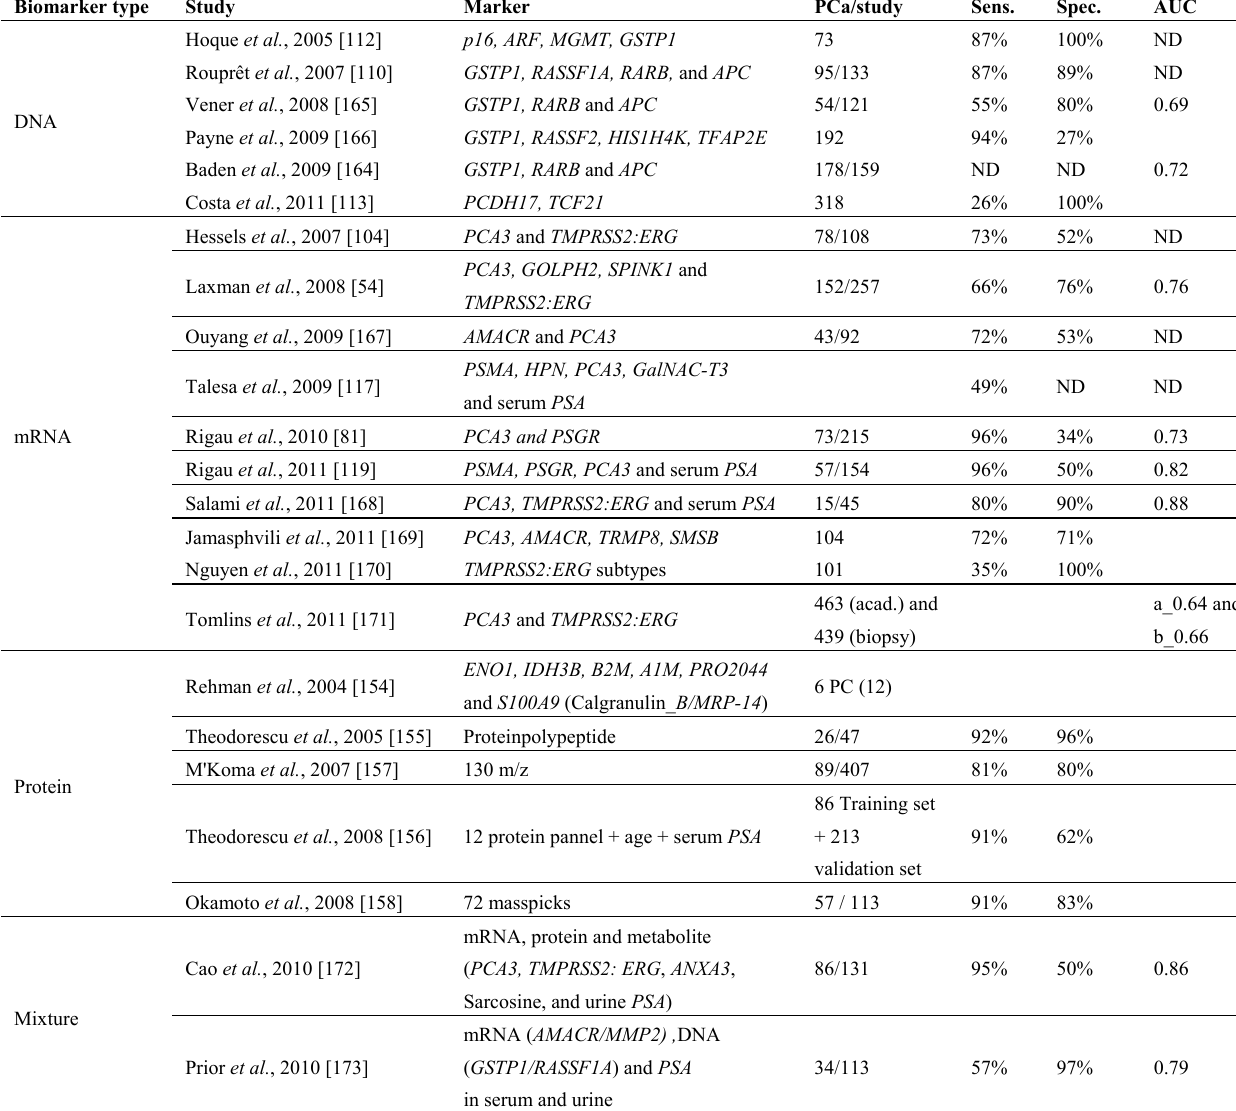
Table 2. Summary of the most significant studies that have used panels of urine biomarkers for PCa